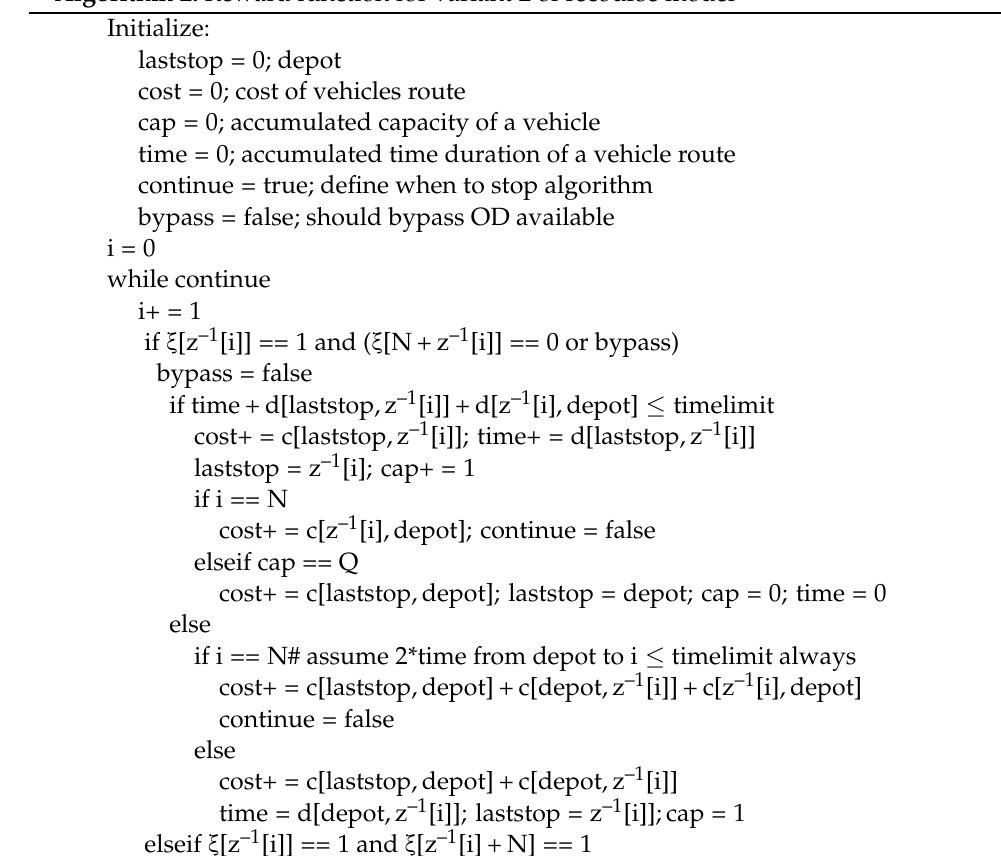
Algorithm 2: Reward function for variant 2 of recourse